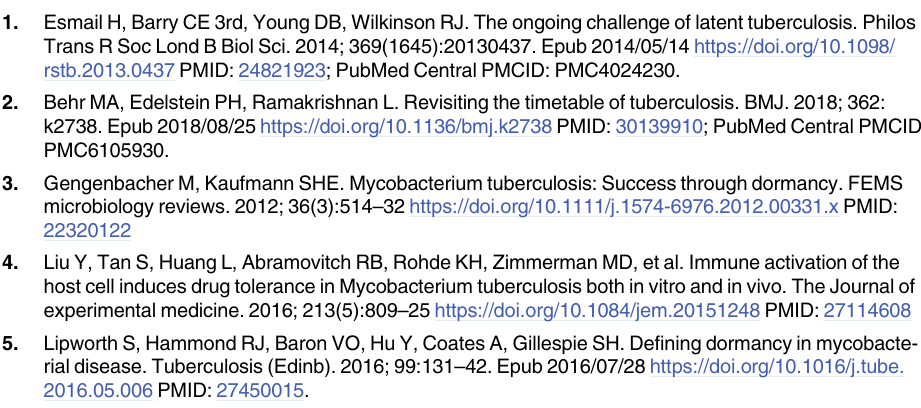
S1 Table. Sequences and references of the primers used for qPCR. S2 Table. Statistical analysis of Fig 5C and 5D. Statistical analysis was performed using a gen- eralized linear mixed-effects model; n.s., not significant; � , p < 0.05, �� , p < 0.01; ��� , p < 0.001; ���� , p < 0.0001. S1 Data. Raw data used to generate the figures on this manuscript. Each row contains the values from one independent